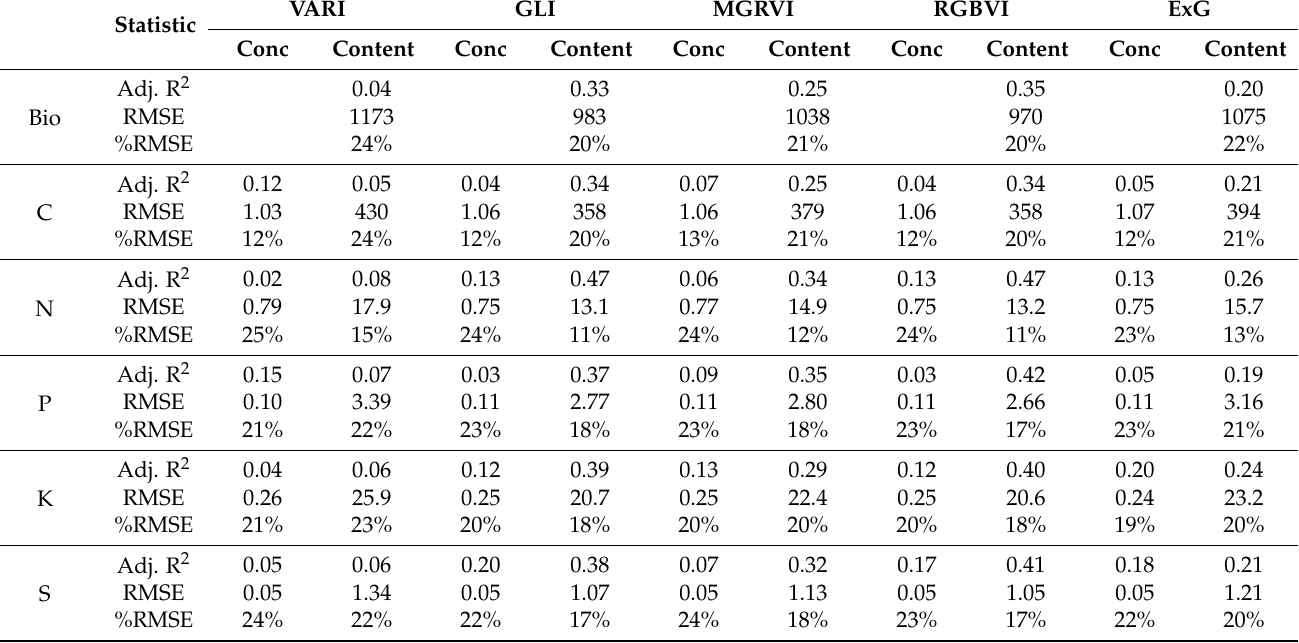
Table 6. Root mean square error (RMSE), %RMSE, and coefficient of determination (R 2 ) for repeated K-fold cross validation of cereal rye biomass (Bio), nutrient concentration, and content-based models for different vegetation indices developed using the simple